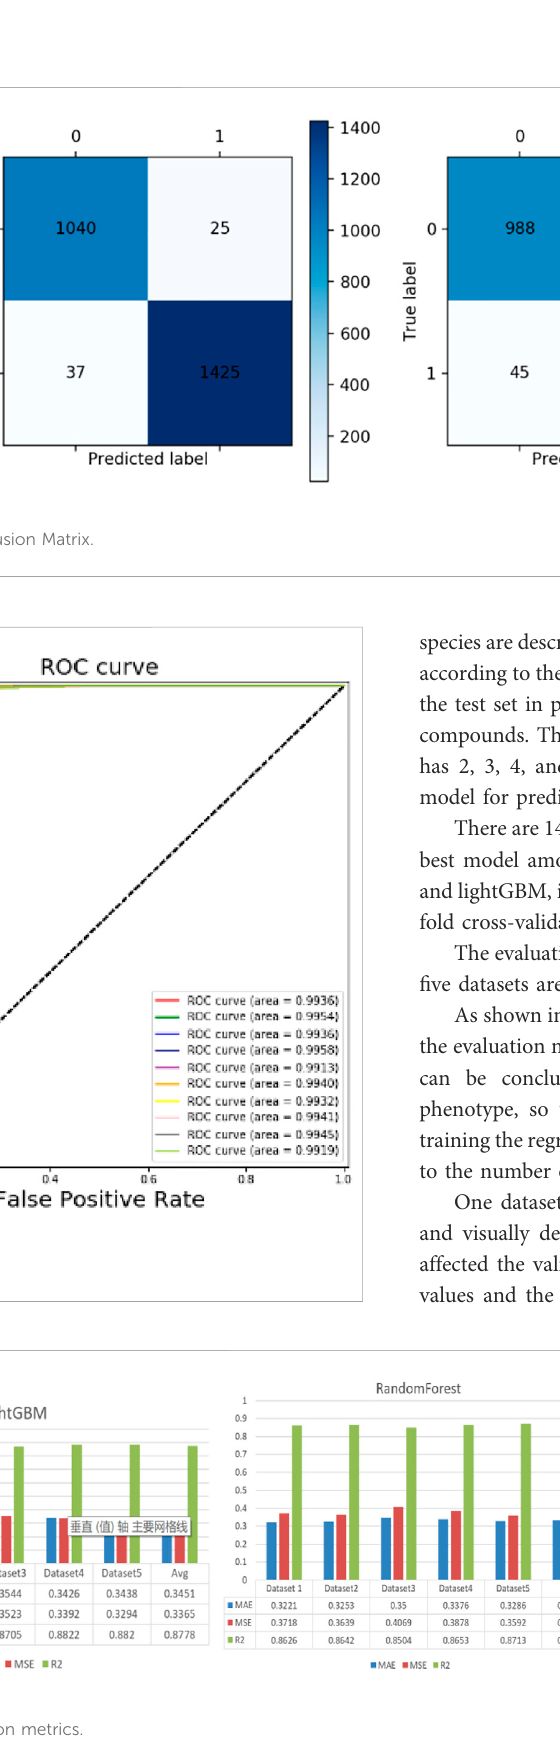
FIGURE 5 Three models evaluation